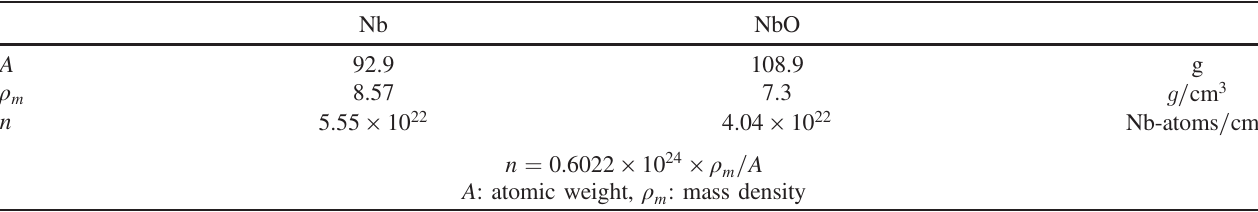
A : atomic weight, ρ